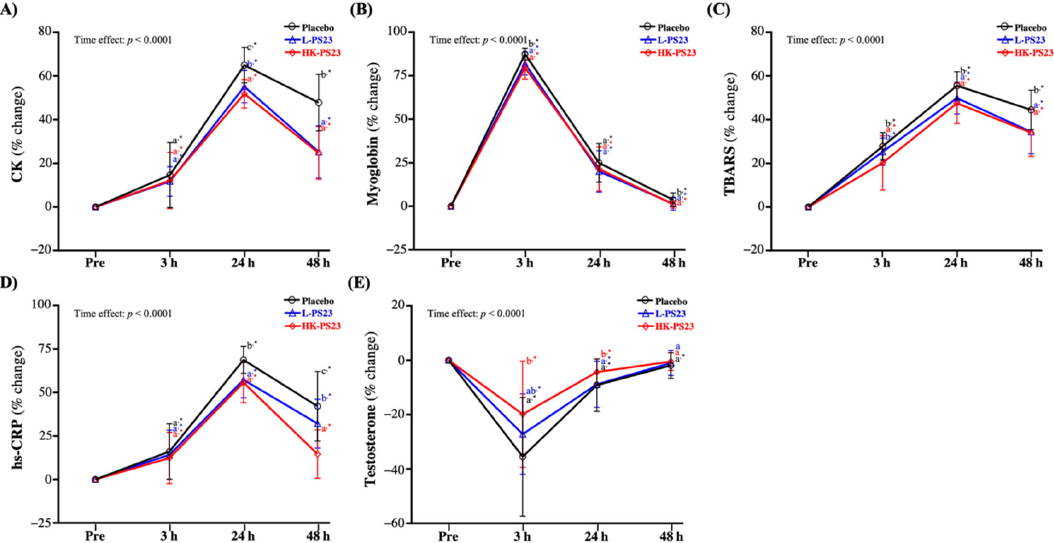
Figure 5. Effects of 6 weeks of L-PS23 and HK-PS23 supplementation on blood ( A ) CK, ( B ) myoglobin, ( C ) TBARS, ( D ) hs-CRP, and ( E ) testosterone. Data are expressed as mean ± SD for n = 35 subjects per group. Different superscript letters (a, b, c) indicate significant difference between groups at same time point ( p < 0.05). * indicates that each group is significantly different from pre-EIMD at different time points ( p < 0.05). CK, creatine kinase; TBARS, thiobarbituric acid reactive substances; hs-CRP, high sensitivity C-reactive